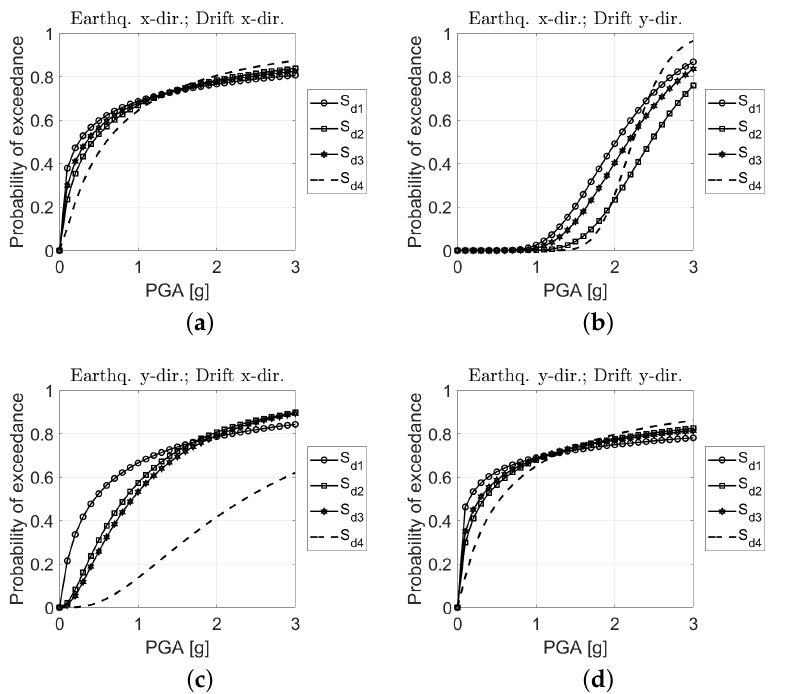
Figure 27. Fragility curves of the masonry tower based on numerical results: ( a ) Earthquake in X direction, drift in X direction; ( b ) Earthquake in X direction, drift in Y direction; ( c ) Earthquake in Y direction, drift in X direction; ( d ) Earthquake in Y direction, drift in Y